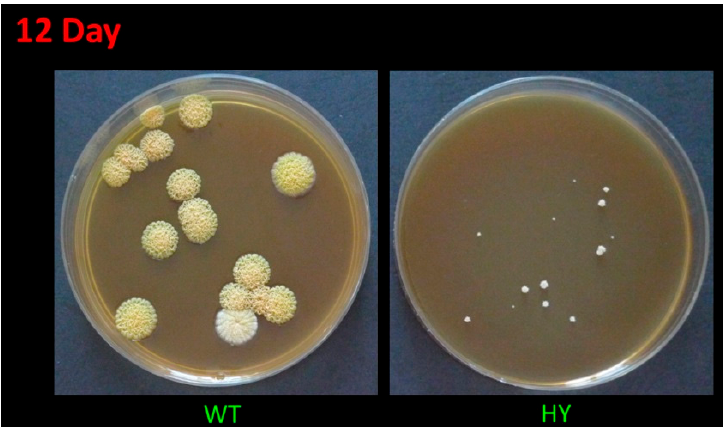
Figure 1. Growth of A. chrysogenum wild-type (WT) and high-yielding (HY) strains after 12 days on agarized complex (CPA) medium.